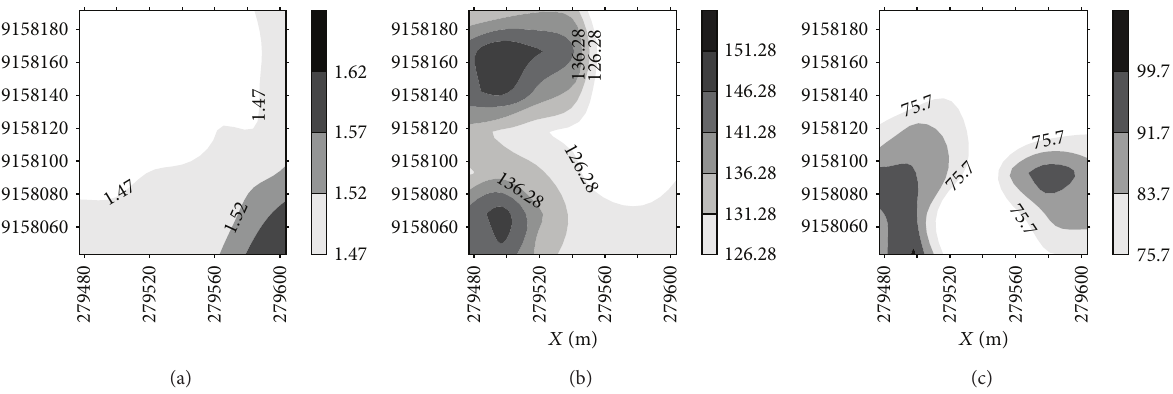
Figure 7: Contour maps of the bulk density from 1.47 gcm −3 (a); preconsolidation tension with soil water content of 10% for tension equal to or greater than 126.28 kPa (b); and preconsolidation tension with soil water content of 19% for tension equal to or greater than 75.70 kPa (c).